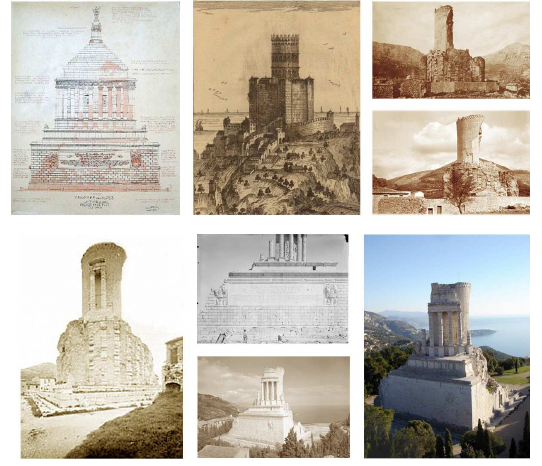
Figure 2. Ancient photographs describing evolution of Trophée des Alpes in the early 20 th century.